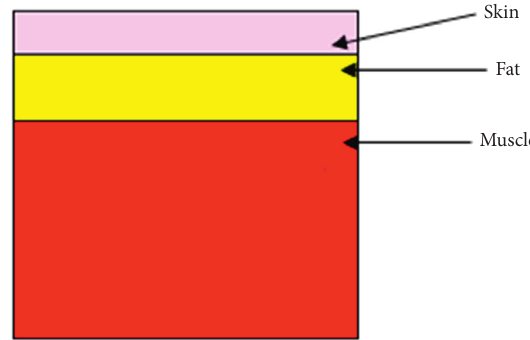
Figure 18: Phantom consisting of three outer most layer of human body. Table 6: Dimension and physical properties of skin, fat, and muscle at 60GHz [25].